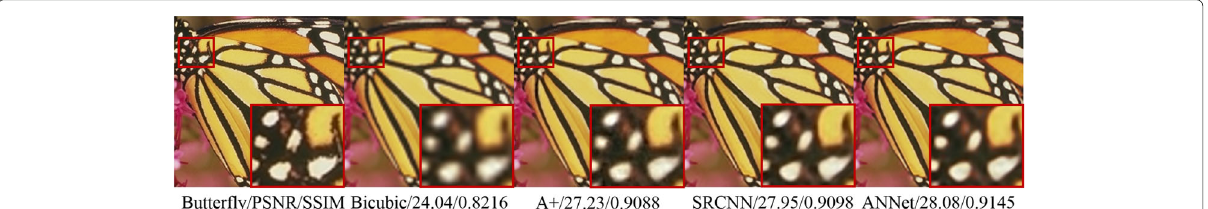
Fig. 4 Visual quality comparison of single-image SR on image butterfly from Set5 [1] with upscaling factor 3